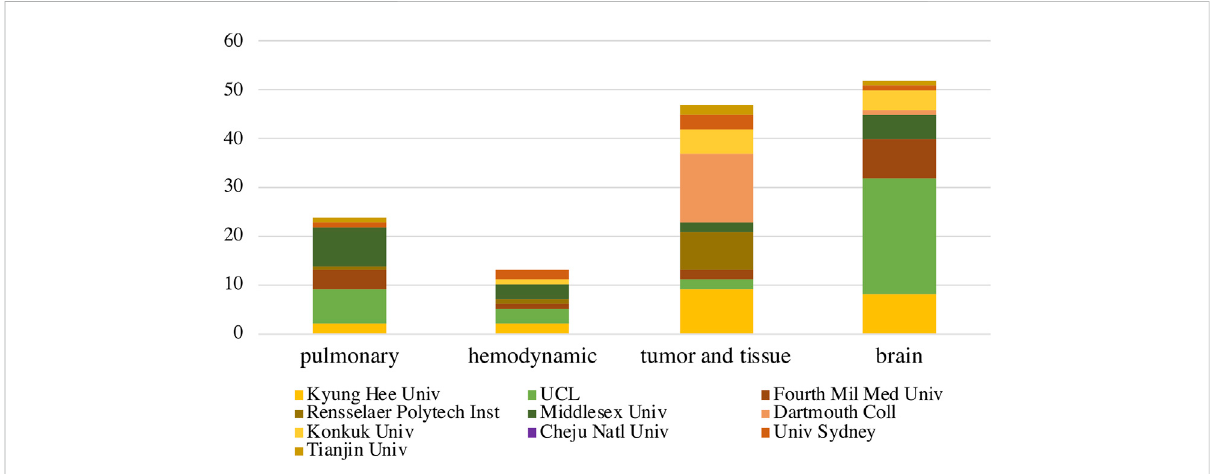
FIGURE 7 The EIT hardware publications by top 10 institutes on speci fi c applications. The X -axis represented application fi eld of “ pulmonary ” , “ hemodynamics ” , “ tumor and tissue ” and “ brain ” , the Y -axis represented the publication proportions listed by publication number. The colour represented institute. The color areas represented the publication number.